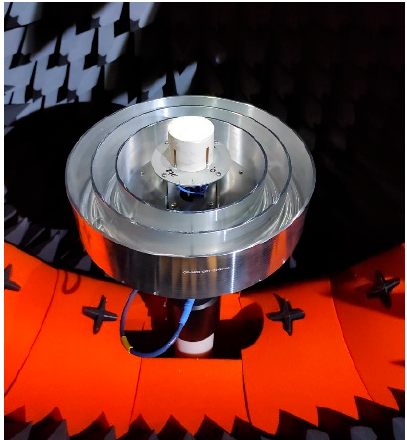
Figure 4. DLR in-house developed antenna with choke rings, as shown in [22], in the anechoic chamber.